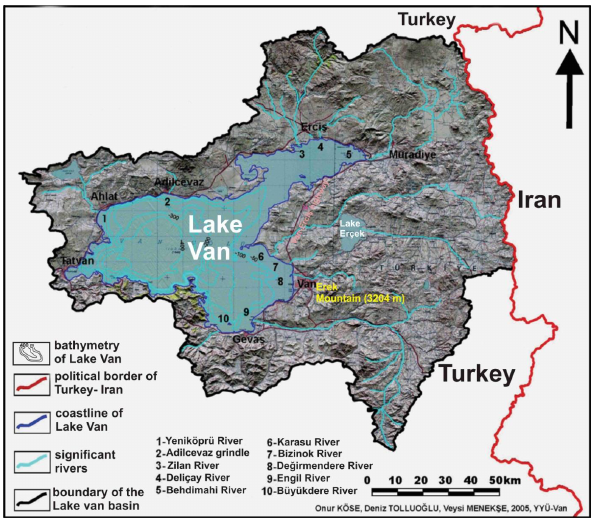
Figure 3. The 3D morphologic view of the Van Region (Köse et al., 2005). 2 Fig. 3. The 3-D morphologic view of the Van region (K¨ose et al.,